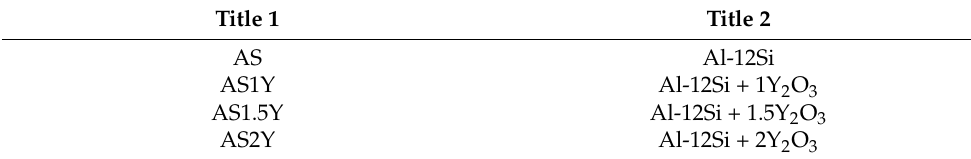
Table 2. Samples and composition (wt.%) of